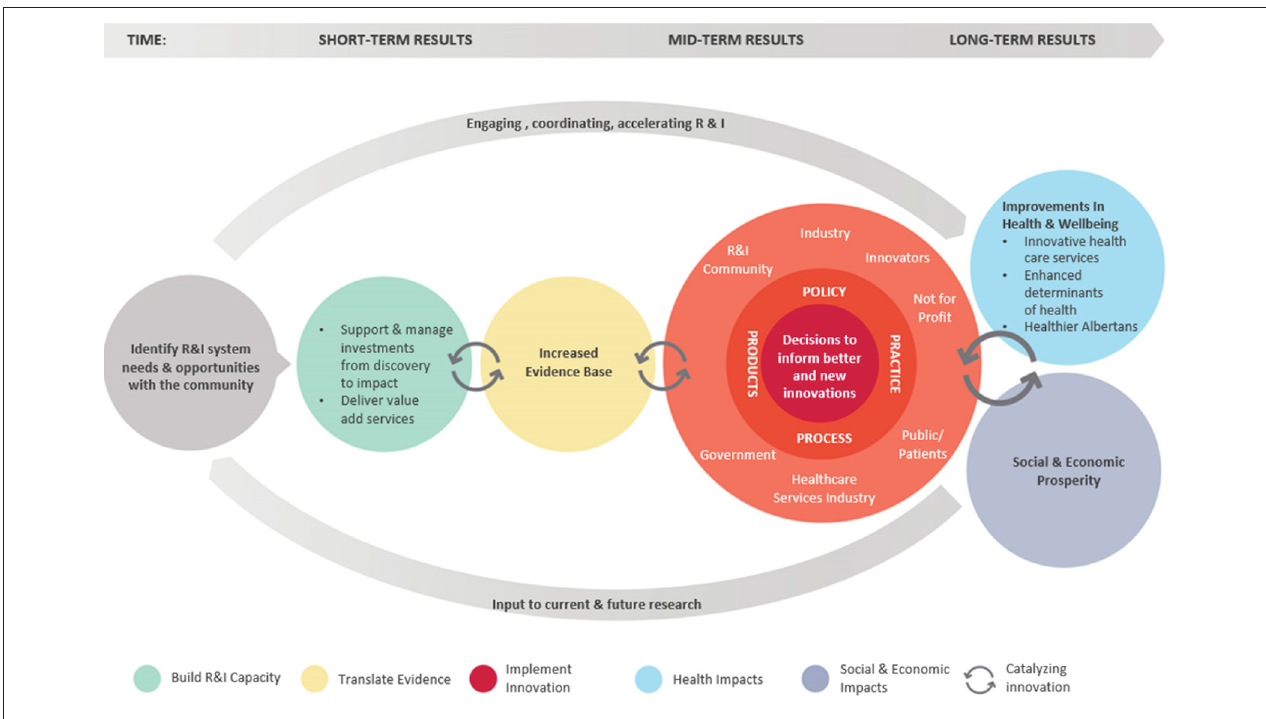
FIGURE 1 | AIHS Health Research Impact